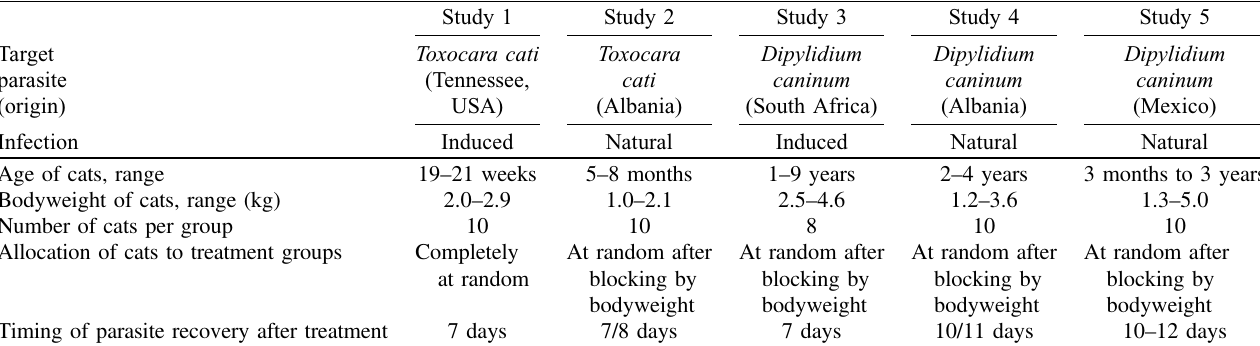
Table 1. Study-speci fi c information: animal details, allocation, and target parasites.